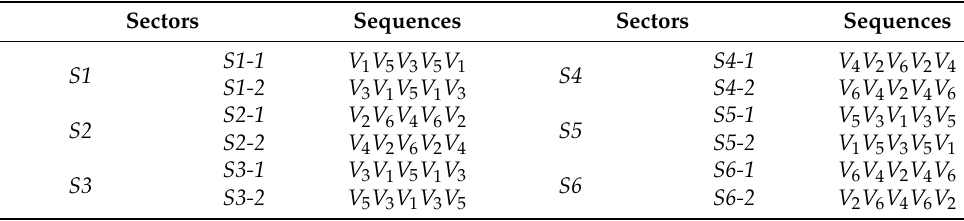
Table 3. Voltage vector action sequences under CMRSVPWM